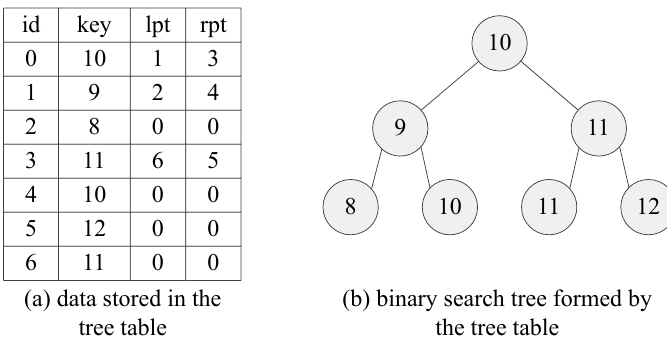
(b) binary search tree formed by the tree table